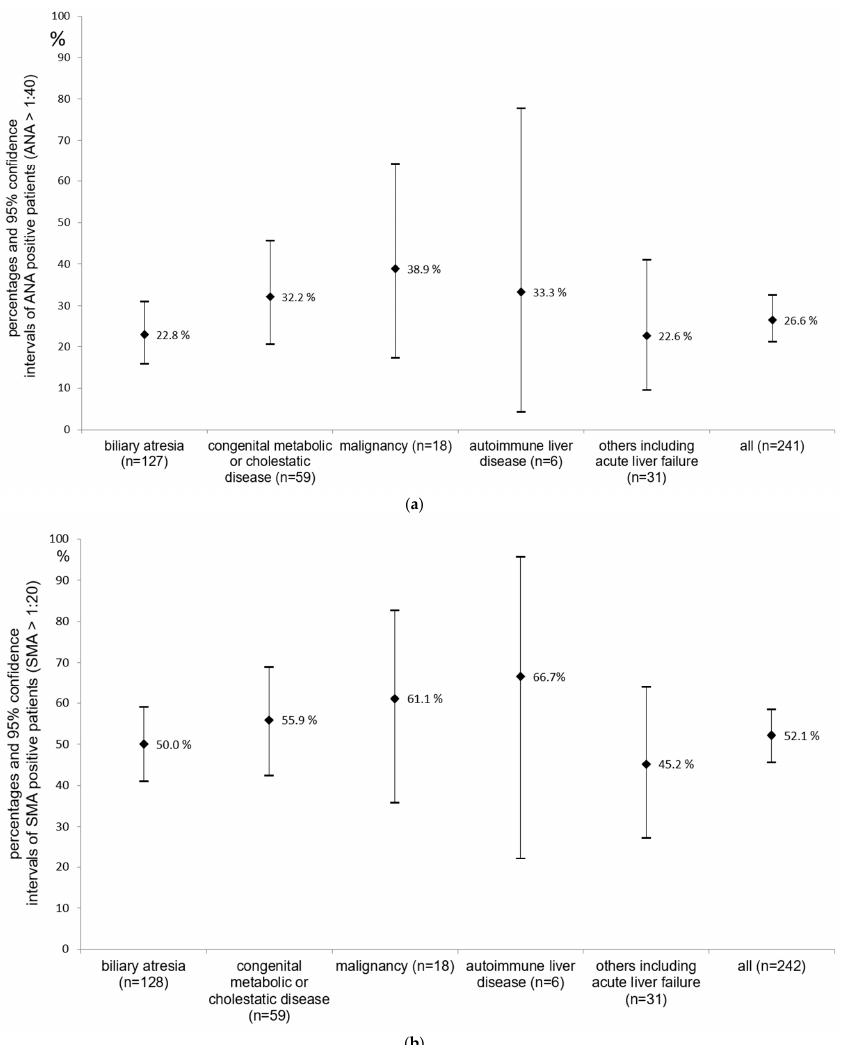
Figure 1. ( a ) ANA positivity depending on disease (percentages and 95% confidence intervals). ( b ) SMA positivity according to disease (percentages and 95% confidence intervals).